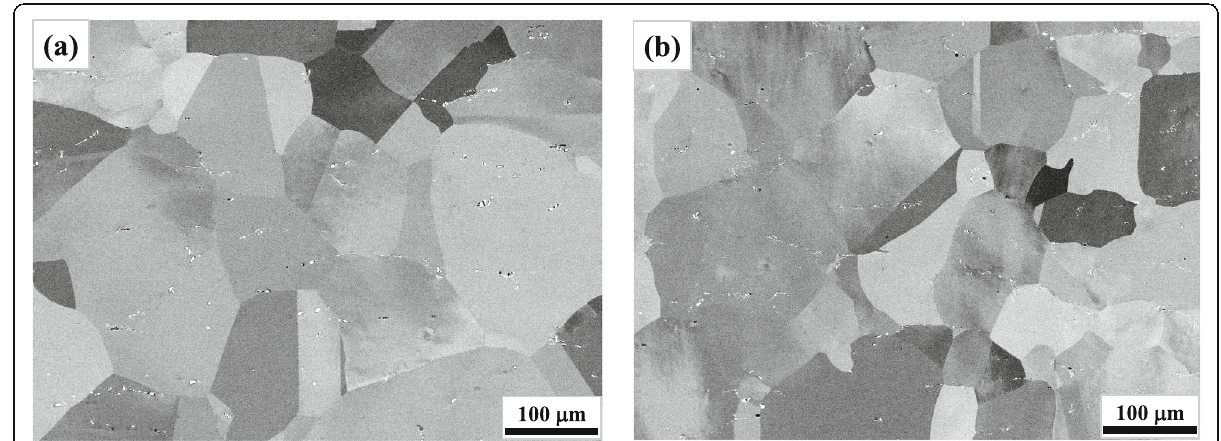
Fig. 2 Initial microstructures prior to oxidation: a W0, b